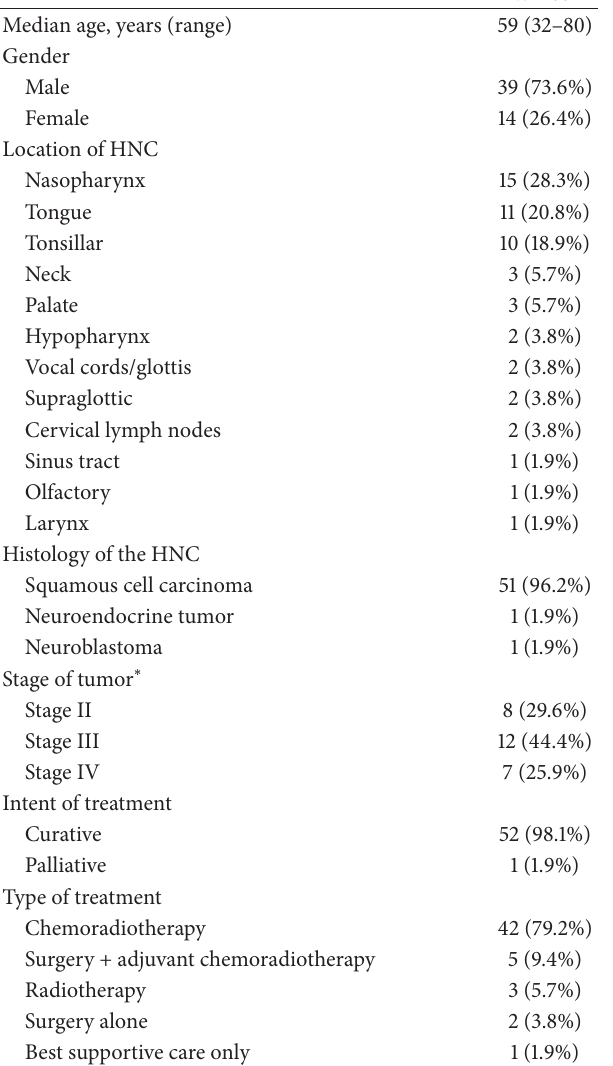
Table 1: Demographic characteristics of 53 patients with head and neck cancer referred to our department for PEG insertion.